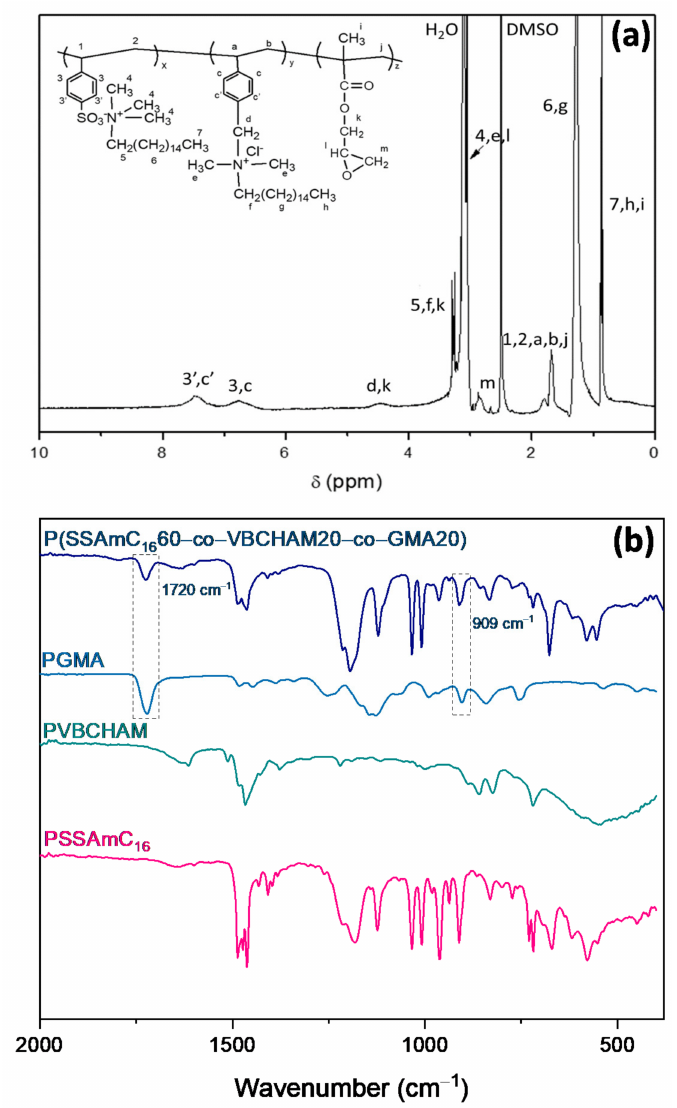
Figure 2. ( a ) The 1 H-NMR and ( b ) ATR-FTIR spectra of the terpolymer P(SSAmC 16 -co-VBCHAMx-